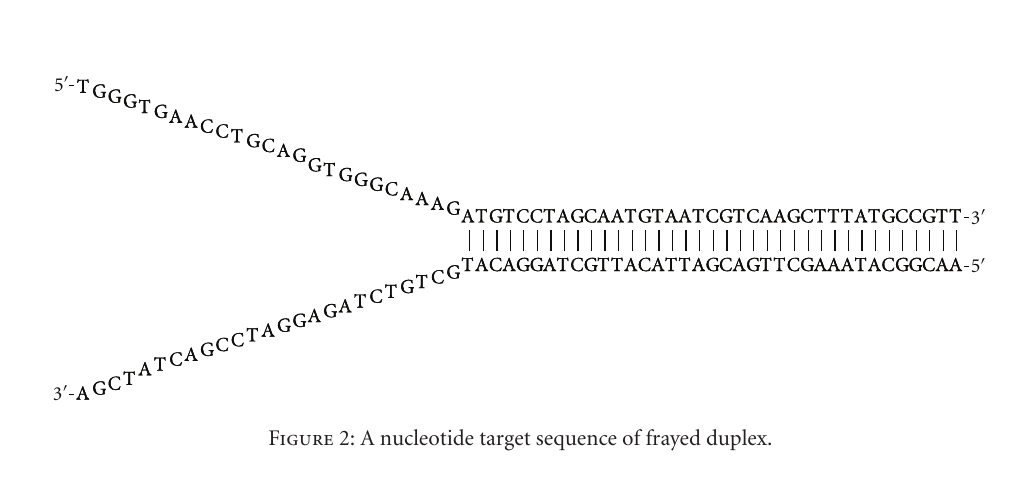
Figure 2: A nucleotide target sequence of frayed